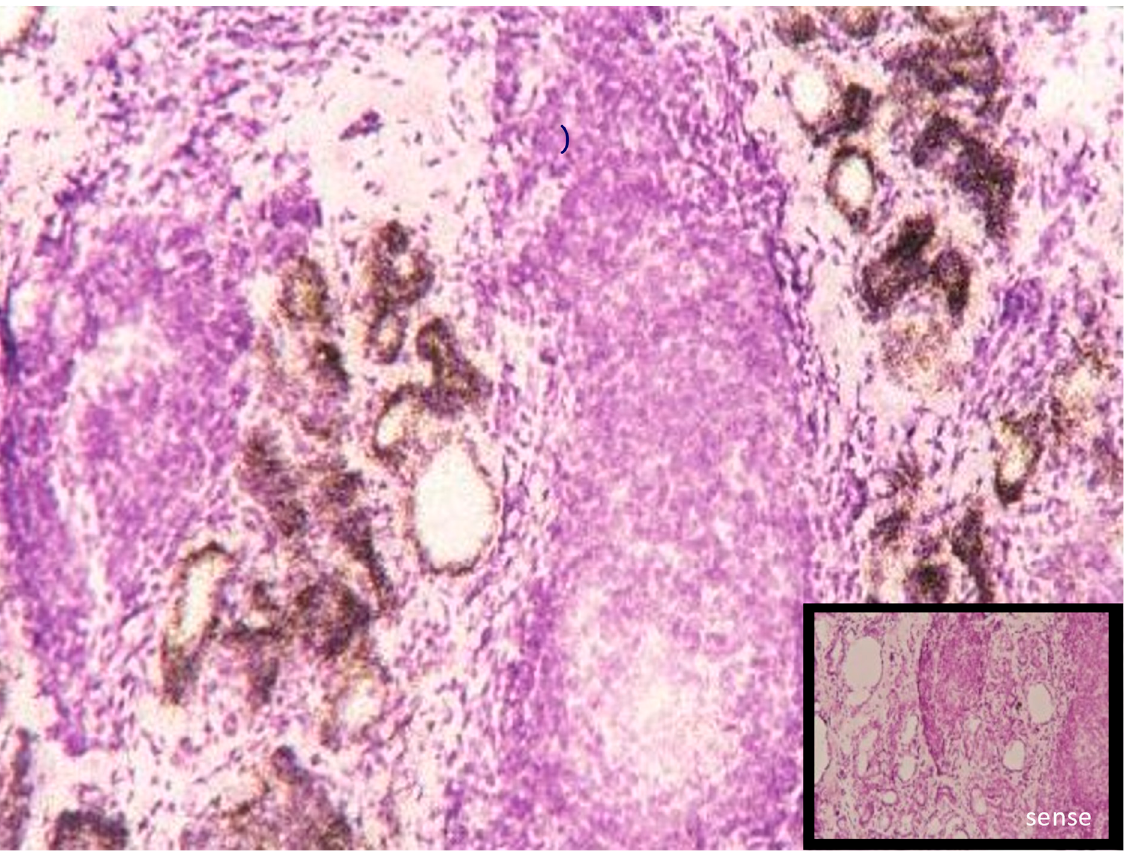
Figure 4. Expression of pGPx (Gpx3) mRNA detected in in situ hybridization (12 μ m cryosection) of a human thyroid gland specimen, thyroidectomized for severe Hashimoto’s thyroiditis. Residual angiofollicular units stained for pGPx (brown); H&E stain of infiltrating lymphocytes; insert: negative control staining with an antisense pGPx probe. (Reproduced with permission from Figure 1C [6], Schmutzler C. et al. Biol. Chem. (2007), 388 , 1053–1059; DOI:10.1515/BC.2007.122).